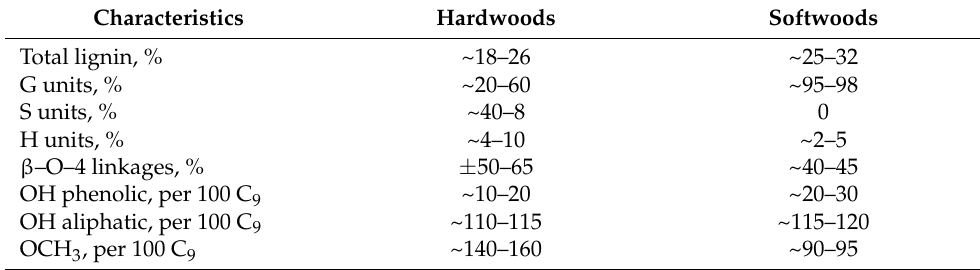
Table 1. Structural features of native lignin [33–37].